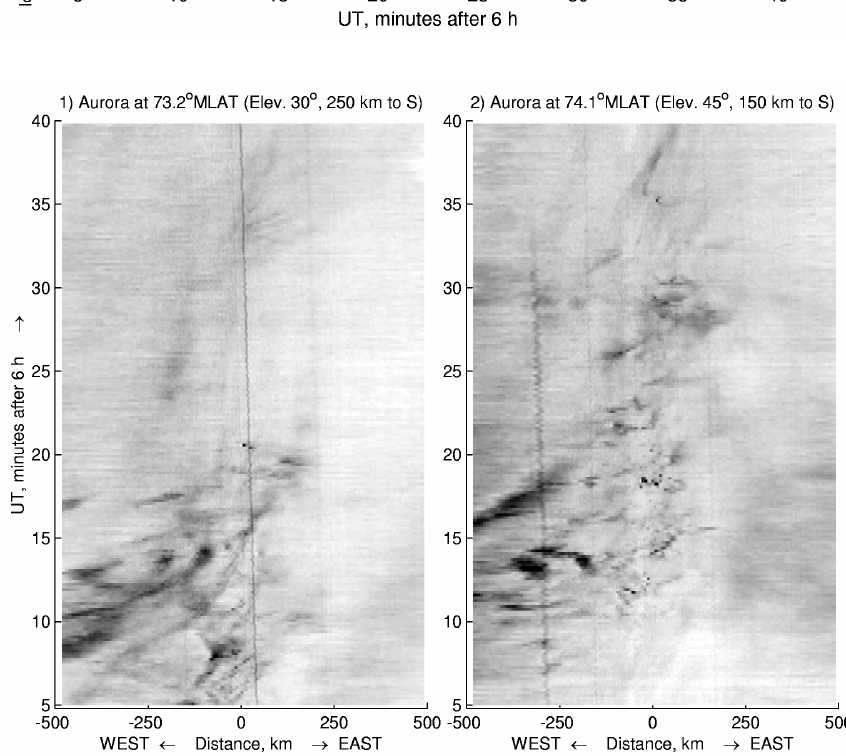
Fig. 5. Top panel: The keogram demon- strating poleward propagation of the au- roral forms (rayed arcs) originated af- ter the IMF turning to strongly north- ward. These arcs followed each other at a spatial separation of the order of 80km. Six arcs (indicated by num- bers) were identified, and velocities of their poleward propagation were cal- culated from the keogram. Bottom panel: The plasma velocity component (solid line) is presented together with the velocities of the arcs drifting along the same direction (open circles and crosses). Dashed lines represent the ve- locity error range, whose value includes the measurement errors and also the un- certainties because of unknown field- aligned and across-beam components.